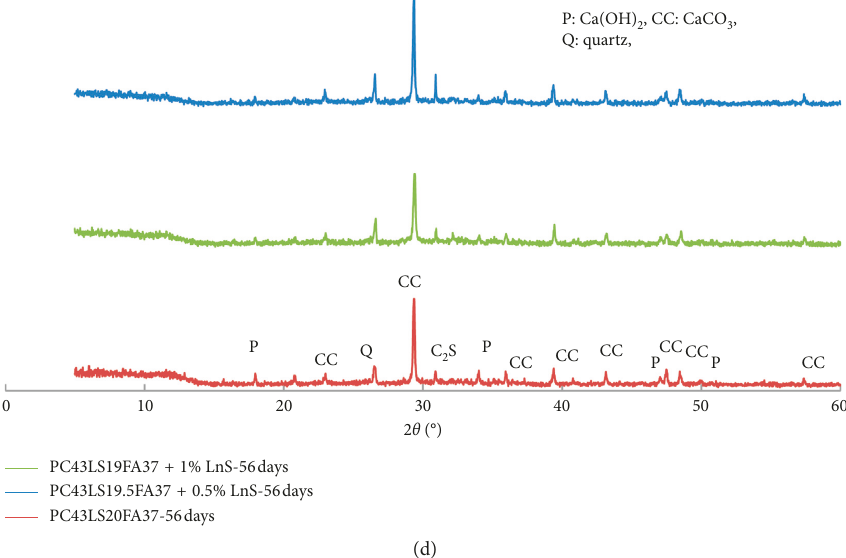
Figure 16: XRD pattern of LnS nanocomposite binders based on PC43LS20FA37 at (a) day 1, (b) day 7, (c) day 28, and (d) day 56.